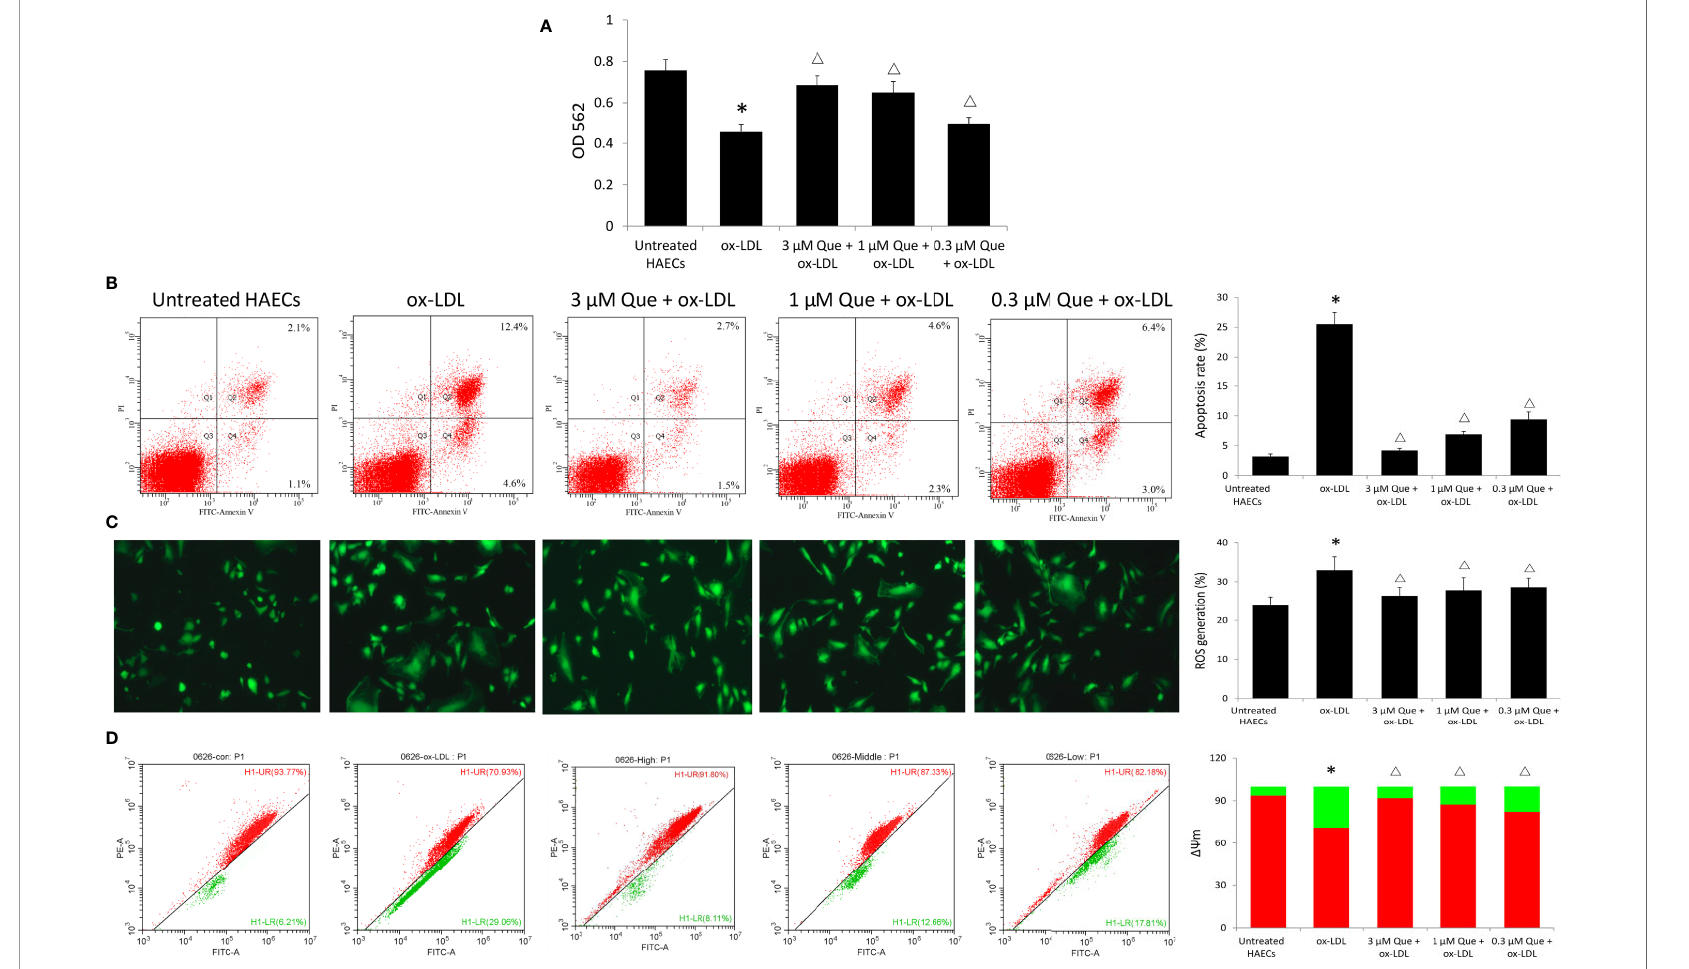
FIGURE 3 | Effect of Quercetin on apoptosis, reactive oxygen species (ROS), and DY m. Human aortic endothelial cells (HAECs) were cultured for 48 h in the presence of 50 m g/ml ox-LDL, or 50 m g/ml ox-LDL followed with different quercetin (3, 1 or 0.3 m mol/L), and untreated HAECs was used as normal control. (A) viability of HAECs was determined by MTT assay. (B) Apoptosis rate was determined by Annexin V-FITC/ PI. (C) ROS generation was determined by 2',7'-dichloro fl uorescin diacetate (DCFH-DA). (D) The degree of mitochondrial depolarization and DY m was assayed by JC-1 staining and DY m was assessed by the relative ratio of red fl uorescence to green fl uorescence via fl ow cytometer. DY m reversibly changes color from green to red as the membrane potential increases (values of > 80 – 100 mV). * P < 0.05, vs untreated HAECs; Δ P < 0.05, vs ox-LDL; n =